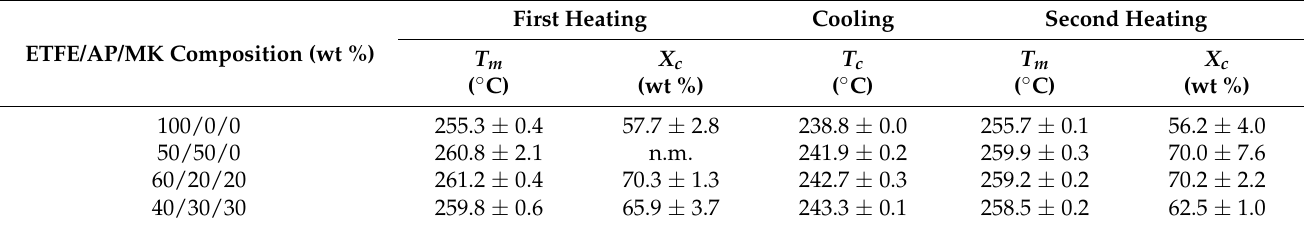
Table 1. DSC analysis of selected ETFE/AP/MK composites (n.m. stands for not measurable).